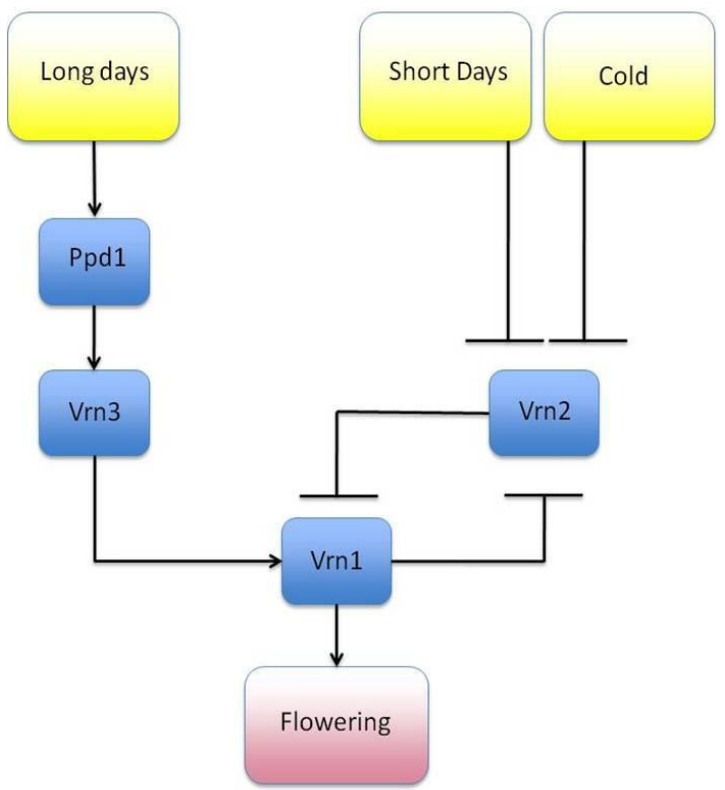
Figure 2. Vernalization and photoperiodicity in Barley. Gene Vrn2 negatively down-regulates gene Vrn1, preventing flowering. During periods of cold, short days, Vrn2 is down-regulated. However a period of long days is required to activate genes Ppd1 and Vrn2, which activate